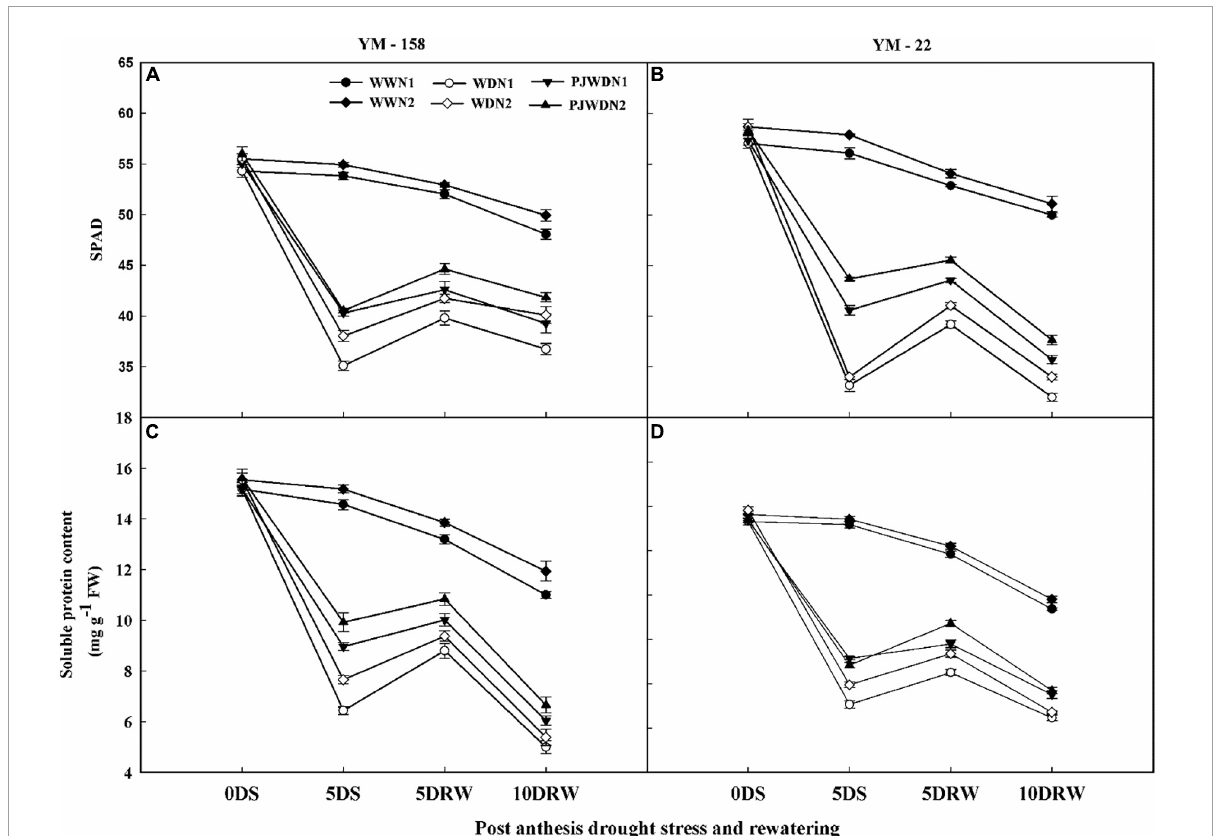
FIGURE5 Effects of pre-drought priming on chlorophyll (SPAD value) and soluble protein content in response to post-anthesis drought stress under two nitrogen (N) rates (N1,180 and N2, 300) in Yangmai-158 (A,C) and Yangmai-22 (B,D) wheat cultivars. Treatments: WW (control), no priming at jointing + no post-anthesis drought stress; PJWD, priming at jointing + post-anthesis drought stress; and WD, no priming at jointing + post-anthesis drought stress. Pre-drought priming was completed during the jointing stage, and post-anthesis drought stress was applied from 7 to 14 days after anthesis. The horizontal axis shows the time course of the sampling: 1 days before drought stress (0DS), 5 days after drought stress (5DS), and 5 and 10 days after re-watering (5DRW and 10DRW). Each vertical bar above the mean value indicates the standard error of three replicates ( n = 3) by using three-way ANOVA at P <